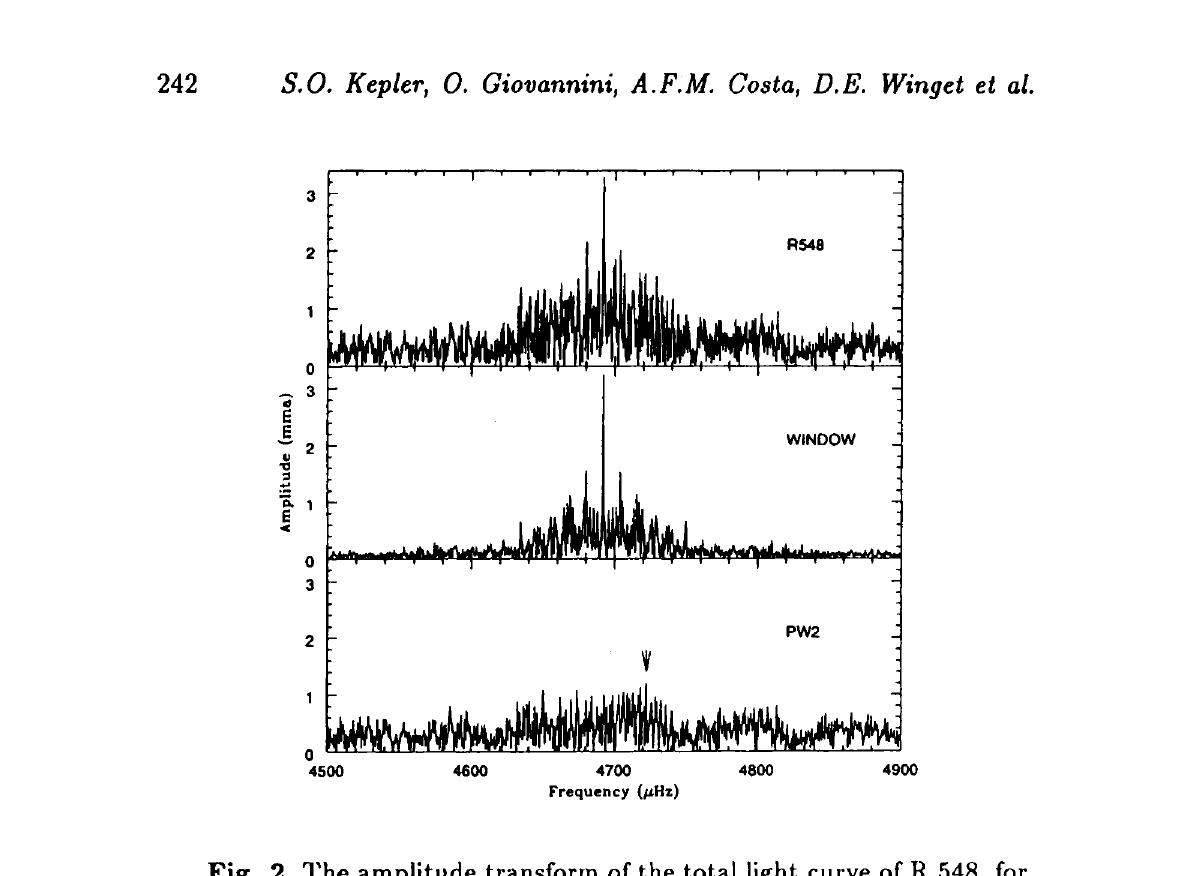
Fig. 2. The amplitude transform of the total light curve of R 548, for the region of the 213 s doublet. The upper panel is the Fourier transform of the data. The second panel (WINDOW) is the spectral window. The third panel (PW2) is the Fourier transform after removing (pre-whitening) the known doublet at P= 213.13 s, >4mp = 3.30 mma and P = 212.76 s, j4mp = 2.06 mma. The largest peak left is at P = 211.76 s, Amp= 1.20 mma, but this peak is less than 2